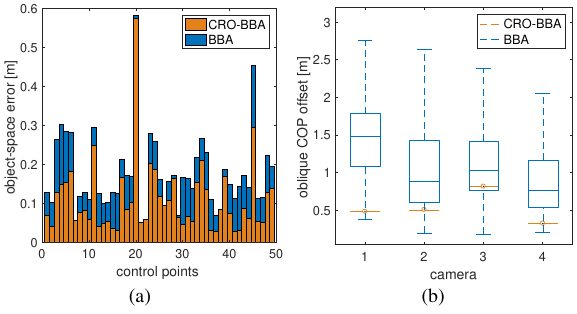
Figure 7. Results of the experiment with real data. (a) Object-space errors for control points; (b) Box plot of the oblique COP offsets. This figure is best viewed in